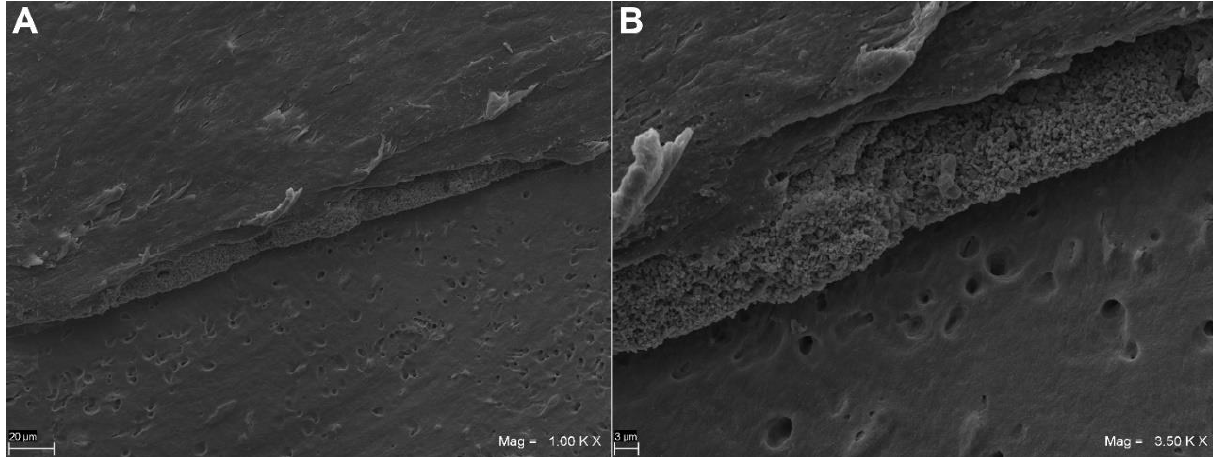
Figure 4. Scanning electron microphotograph (( A ), original magnification 1000×; ( B ), original magnification 3500×) of a sample obturated with zinc-oxide-eugenol-based root canal sealer and warm vertical condensation. Dentinal tubules appear empty.